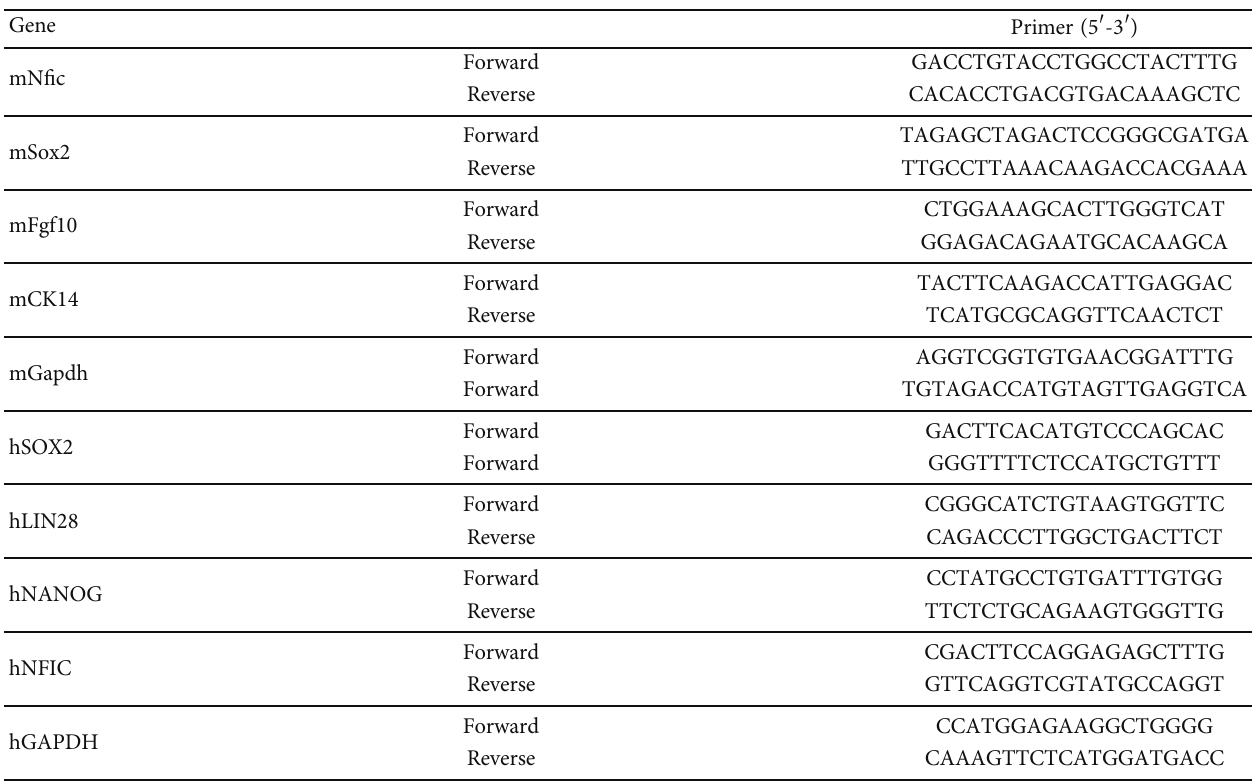
Table 2: Nucleotide sequences of real-time PCR